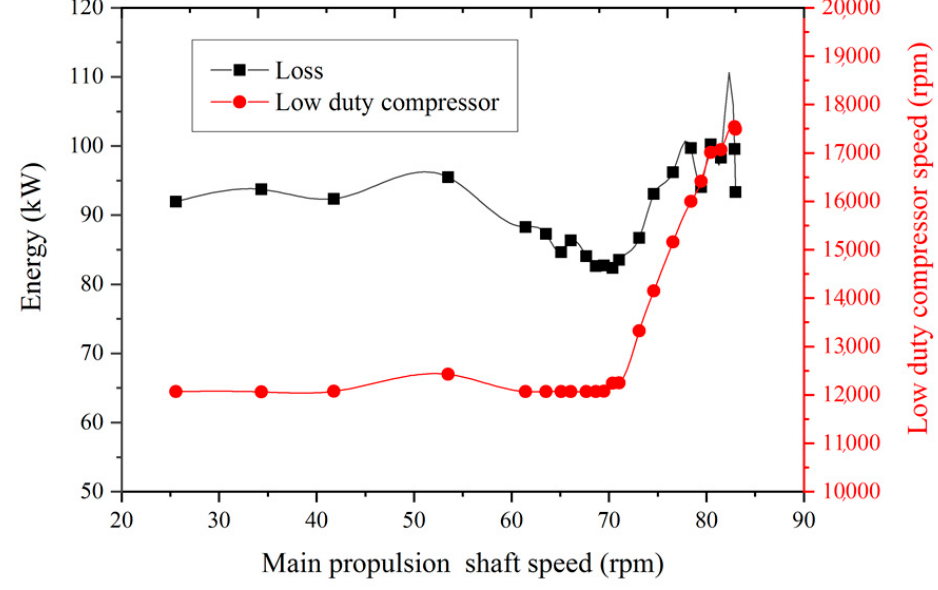
Figure 4. Energy loss vs. turbo compressor